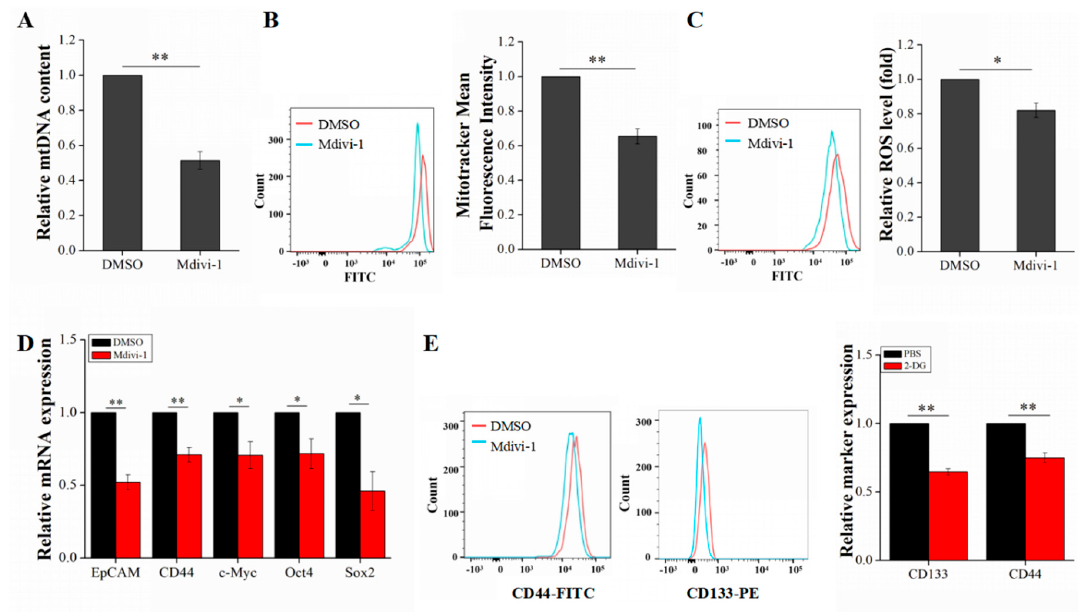
Figure 5. Assessment of mitochondrial biogenesis and stemness gene expression in LCSCs after Mdivi-1 treatment. ( A ) Measurement of the mtDNA copy number after Mdivi-1 treatment. ( B ) Measurement of the mitochondrial mass after Mdivi-1 treatment. ( C ) Measurement of the ROS level after Mdivi-1 treatment. ( D ) Detection of stemness genes after Mdivi-1 treatment. ( E ) Detection of the surface markers CD133 and CD44 after Mdivi-1 treatment. The values are presented as the means ± SD of three independent experiments. n = 4; * p < 0.05; and ** p < 0.01.